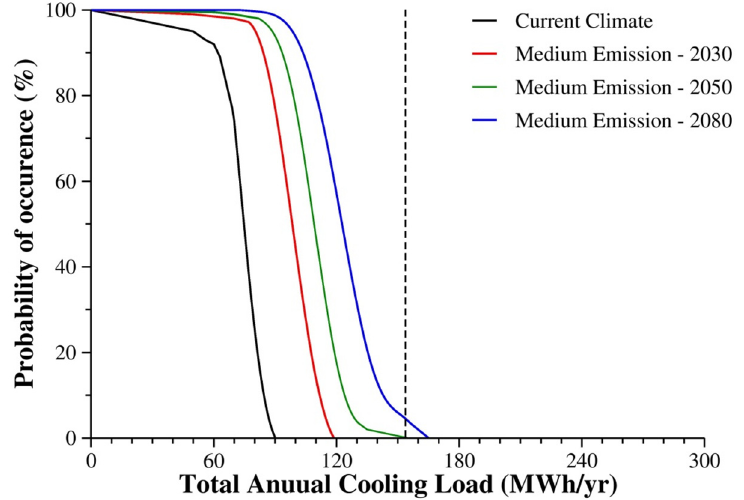
Figure 3. Cooling energy consumption projections in a future climate for an example